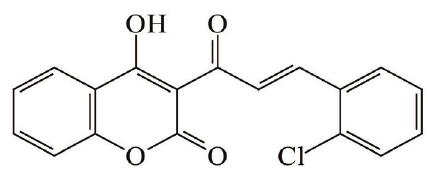
FIGURE 2 - The chemical structure of 3-(3-(2-chlorophenyl) prop-2-enoyl)-4-hydroxycoumarin (Špirtović-Halilović et al. ,